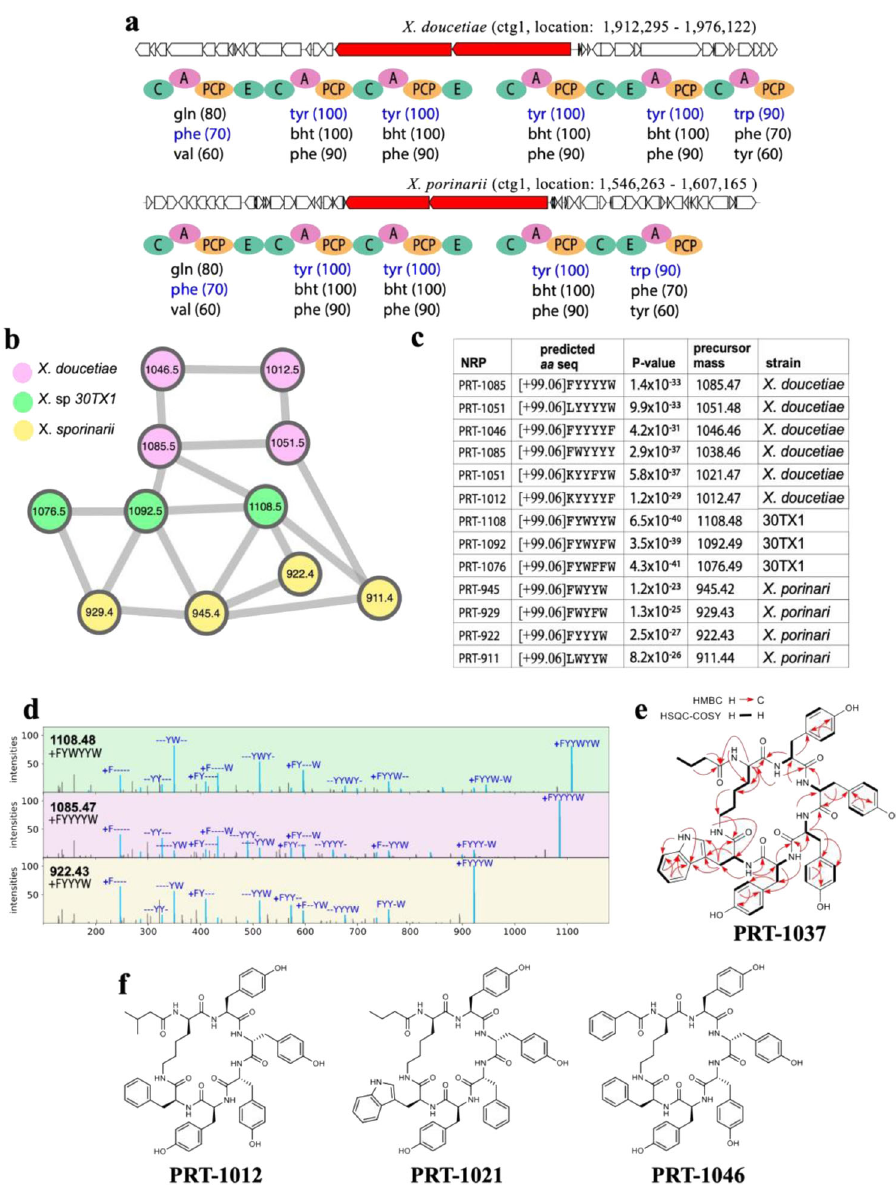
Fig. 3 Identifying protegomycin (PRT) NRP family. a The BGCs generating the NRP in X. doucetiae (top) and X. porinarii (bottom) along with NRPS genes (shown in red) and A-, C-, PCP-, and E-domains in these NRPSs. The rest of the genes in the corresponding contigs is shown in white. No BGC was found in Xenorhabdus sp. 30TX1. Three highest-scoring amino acids for each A-domain in these BGCs (according to NRPSpredictor2 (ref. 15 ) predictions) are shown below the corresponding A-domains. Amino acids appearing in the NRPs [ + 99.06]FYYYYW and [ + 99.06]FYYYW identi fi ed by NRPminer (with the lowest p value) are shown in blue. b Spectral network formed by the spectra that originate from NRPs in the protegomycin family. c Sequences of the identi fi ed NRPs in the protegomycin family (with the lowest p value among all spectra originating from the same NRP). PRT represents protegomycin. For MS details see Supplementary Table 3. The p values are computed based on MCMC approach using MS-DPR 89 with 10,000 simulations. d For each strain, an annotated spectrum representing the lowest p value is shown. The spectra were annotated based on predicted NRPs [ + 99.06]FYYWYW, [ + 99.06] FYYYYW, and [ + 99.06]FYYYW from top to bottom. The “ + ” sign represents the addition of [ + 99.06 Da]. Colors in parts b and d are coordinated. Supplementary Figures 6 – 8 show the annotated spectra for all NRPs shown in part ( c ). e Key HMBC and HSQC-COSY correlations in PRT-1037. f Structures for selected PRT derivatives produced by X. doucetiae including amino acid con fi guration as concluded from the presence of epimerization domains in the corresponding NRPSs and acyl residues as concluded from feeding experiments (Supplementary Fig. 9). Predicted structures for